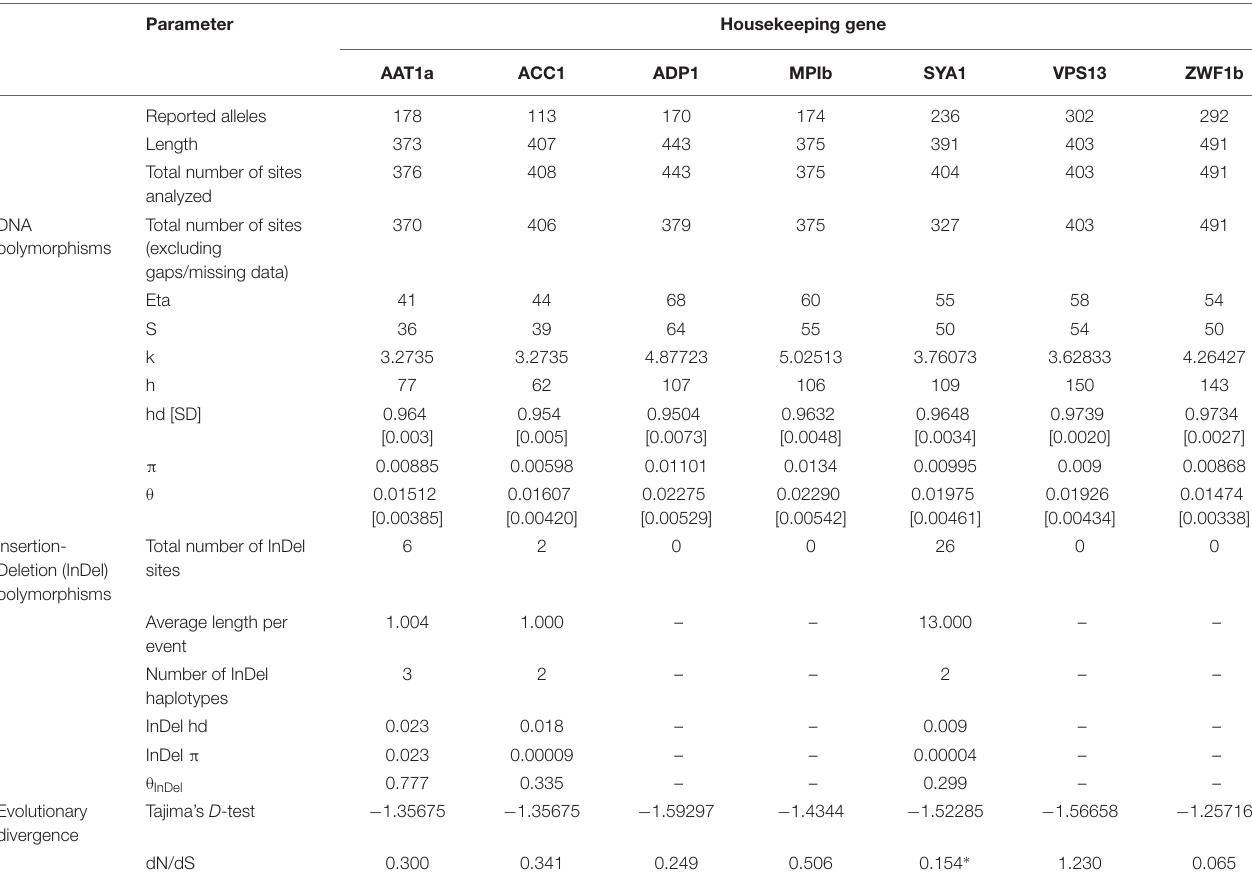
TABLE 1 | Genetic features of the housekeeping gene